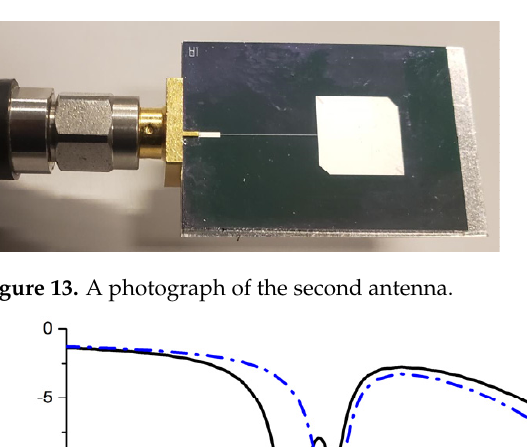
Figure 12. Simulated radiation patterns of the realized gain. ( a ) In the OFF state in a circular polarization; ( b ) in the ON state in a linear polarization.